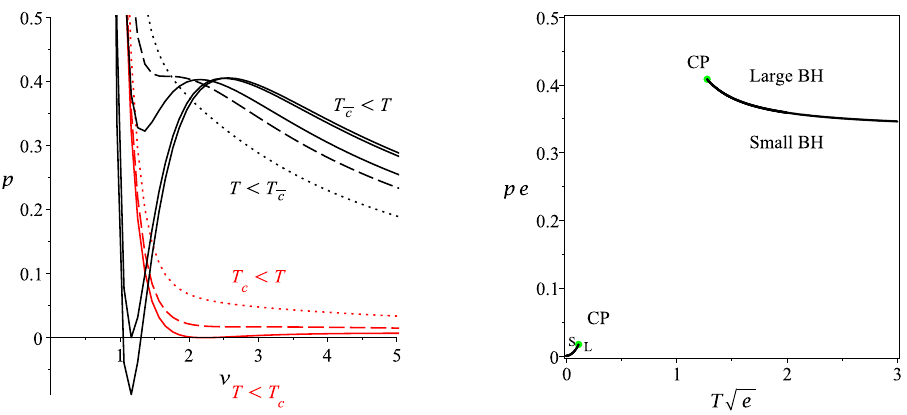
Figure 7 . Van der Waals and reverse Van der Waals phase transition in d = 5 and k = 1 (color online). We choose e = 1, (cid:12) 3 = (cid:0) 4 = 5 e 2 and (cid:11) 4 = (cid:0) 4 = 5 e 3 . Dimensionless critical quantities p p are T c e (cid:25) 0 : 11730, P c e (cid:25) 0 : 01686, T c e (cid:25) 1 : 28065, and P c e (cid:25) 0 : 40771. Left: the behaviour of pressure versus volume for temperatures in the neighbourhood of the critical point at smaller T = T c . We depict the critical curve (dashed red line), T (cid:25) 0 : 65639 T c (solid red line), and T = 1 : 8 T c (dotted red line). We also plot the behaviour in the neighbourhood of the second critical point at larger T = T c . We depict the critical curve (dashed black line), T = 0 : 8 T c (dotted black line), and T = 1 : 1 T c ; 1 : 24282 T c ; 1 : 27 T c (solid black lines). For T > 1 : 24282 T c the pressure becomes negative and the spacetime is no longer asymptotically AdS. Right: coexistence curves for (cid:12)ve dimensional k = 1 charged black holes, with standard VdW behaviour at the lower left and reverse VdW behaviour in the upper right. The critical points are the green